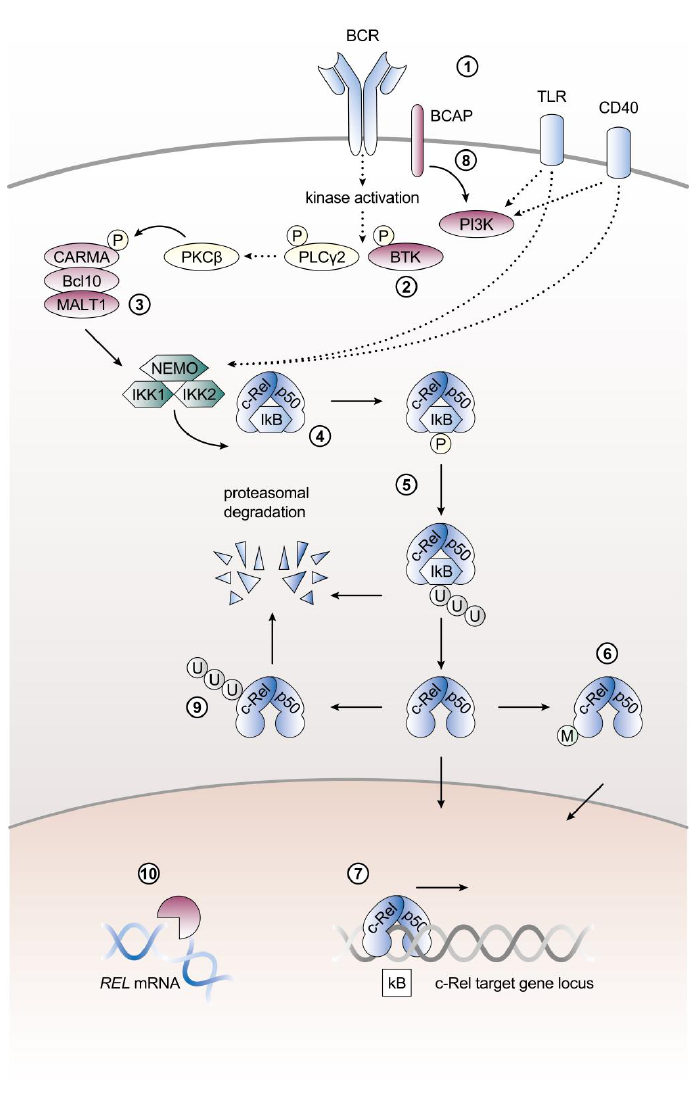
Figure 2. Activation of c-Rel signaling by the canonical NF- κ B pathway in B cells. Major signaling and regulatory components described in the main text are illustrated. ( 1 ) Cardinal triggers of c-Rel signaling include B cell receptor (BCR), toll-like receptor (TLR) or CD40 stimulation. ( 2 ) In Btk-deficient B cells c-Rel DNA-binding activity is strongly reduced following stimulation. ( 3 ) The paracaspase mucosa-associated lymphoid tissue protein 1 (MALT1) which is part of the CBM complex is specifically required for BCR signal-induced c-Rel nuclear translocation. ( 4 ) In mature B cells the predominant NF- κ B dimers are formed by c-Rel and p50. ( 5 ) c-Rel is sequestered in the cytoplasm by interaction with the inhibitory proteins I κ B α , I κ B β and I κ B ε . Various upstream stimuli of canonical NF- κ B signaling can target these I κ B proteins for proteasomal degradation. ( 6 ) c-Rel is modified on a post-translational level. These post-translational modifications (M) can influence c-Rel transactivation and transforming activity. ( 7 ) Once released from the inhibitory I κ B proteins, c-Rel translocates into the nucleus and binds to κ B target sites to exert its function as a transcription factor. ( 8 ) PI3K signaling contributes to maintaining c-Rel levels in B cells. ( 9 ) Regulation of c-Rel is mediated by ubiquitination and subsequent proteasomal degradation. ( 10 ) REL mRNA levels are controlled on a post-transcriptional level. References as